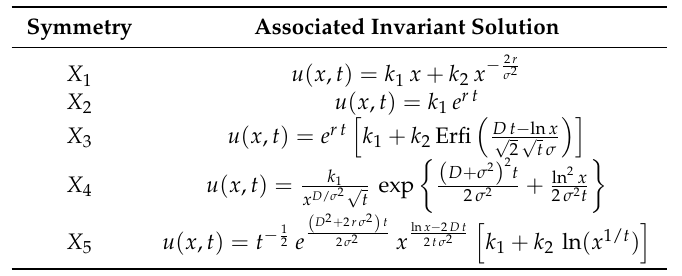
Table 1. Invariant solutions of the Black-Scholes Equation (1).